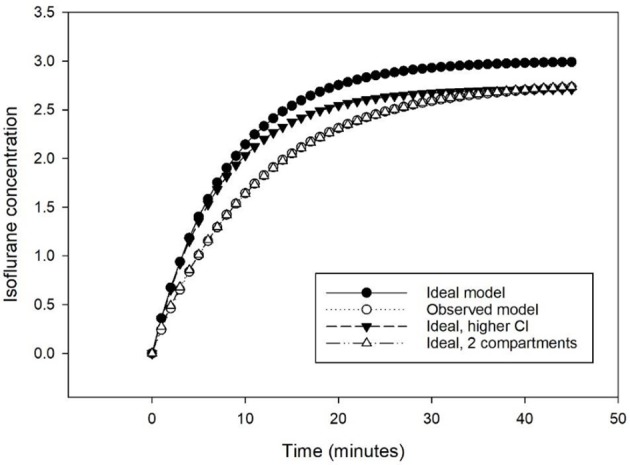
Predicted isoflurane time course to increase from 0 to 3% at 5 L min−1 following a one-compartmental model of 40 L and an elimination of 5 L min−1 (Ideal model), with an elimination of 5.52 L min−1 (Ideal, higher Cl), and with a 2-compartments model of 40 L and an elimination of 5.52 L min−1 (Ideal, 2 compartments), compared to the observed time course (Observed model).